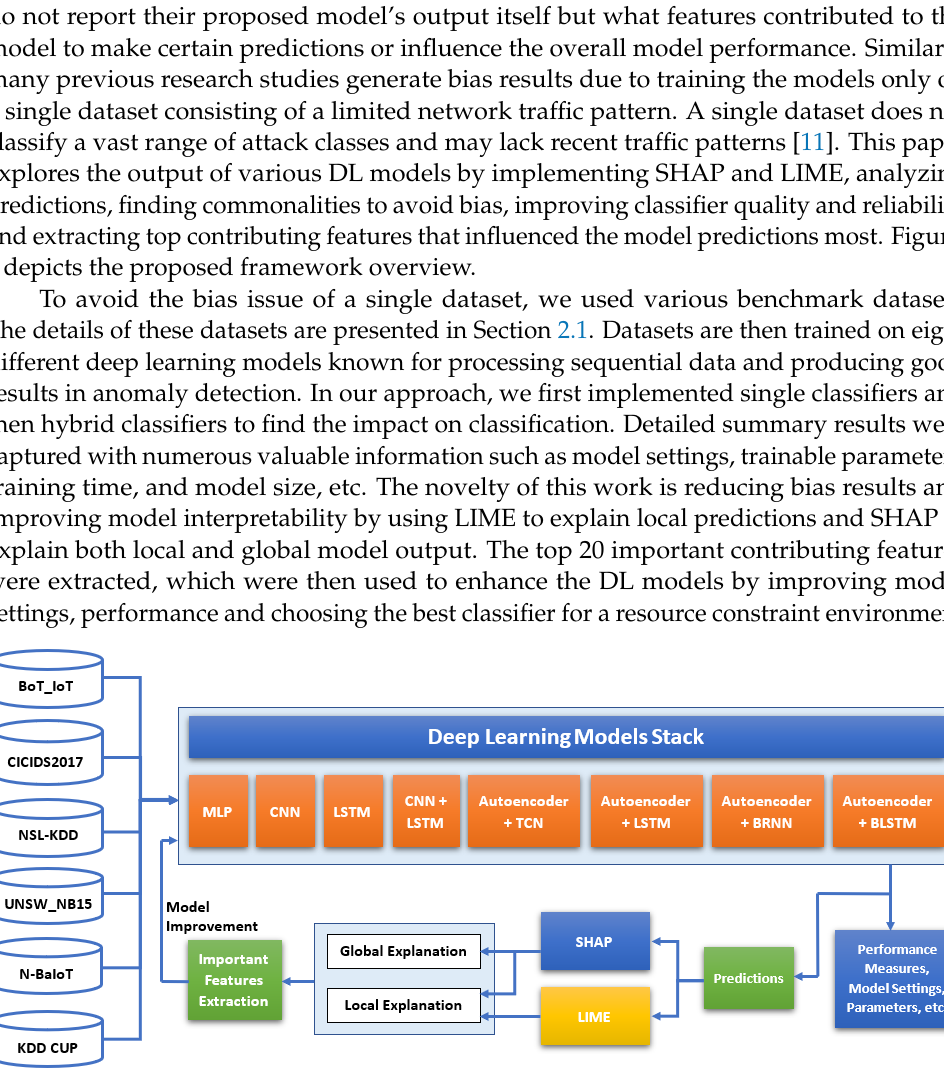
Figure 1. Overview of the proposed